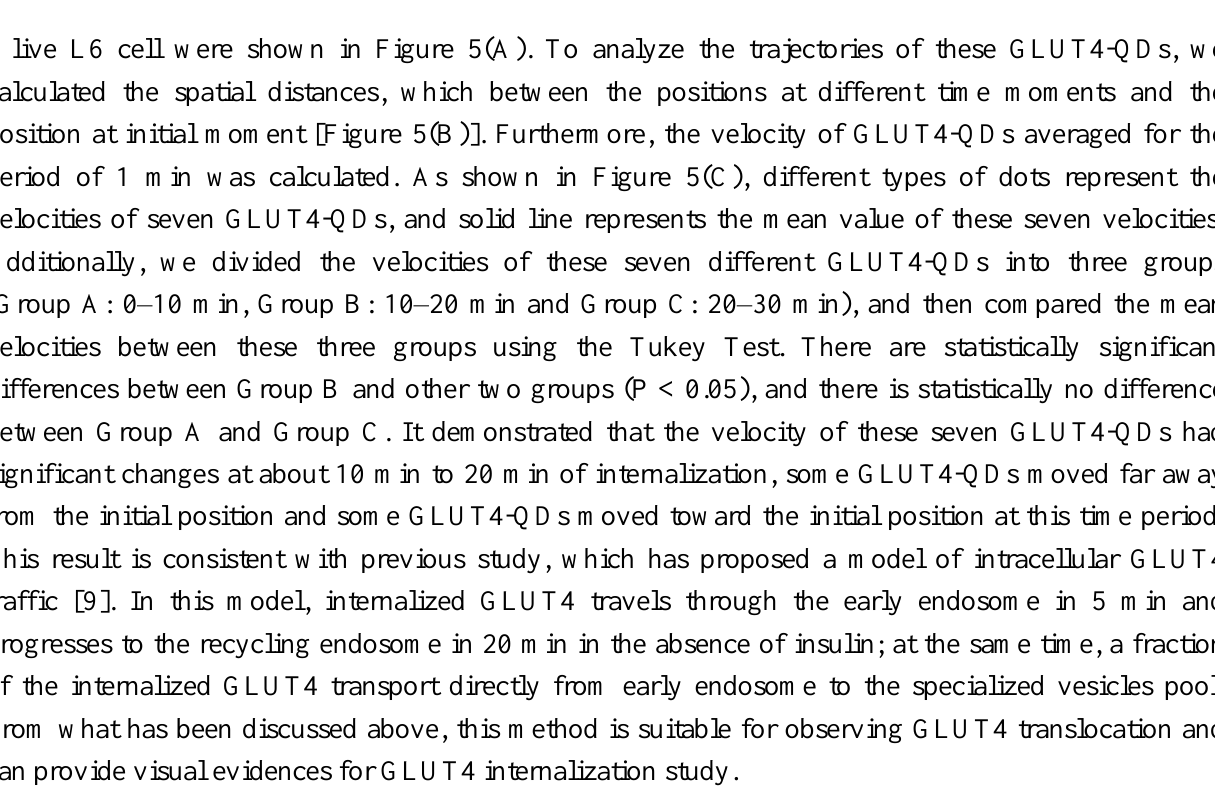
Figure 5. Trajectory analysis for GLUT4-QDs. (A) Trajectories of three GLUT4-QDs in a L6 cell. (B) Spatial distances between the positions at different time moments and the position at initial moment of three GLUT4-QDs. Two GLUT4-QDs moved far away from the initial position and one GLUT4-QD moved toward the initial position at about 15 min after endocytosis. (C) Velocities of seven different GLUT4-QDs averaged for the period of 1 min (dots), and mean value of these seven velocities (solid line). The velocities of these seven GLUT4-QDs had significant changes at about 10 min to 20 min of